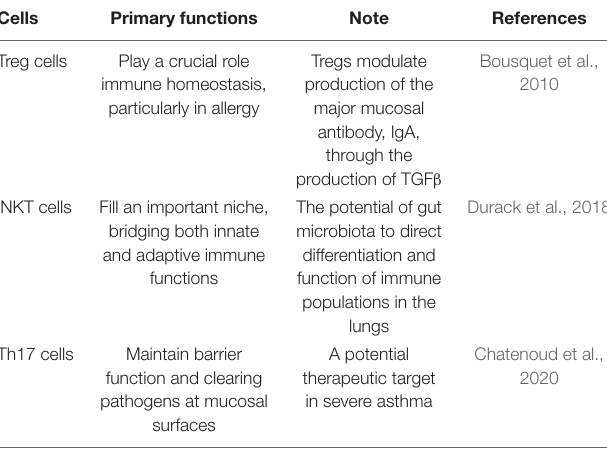
TABLE 2 | Important cells in these pathways and stated their effects.